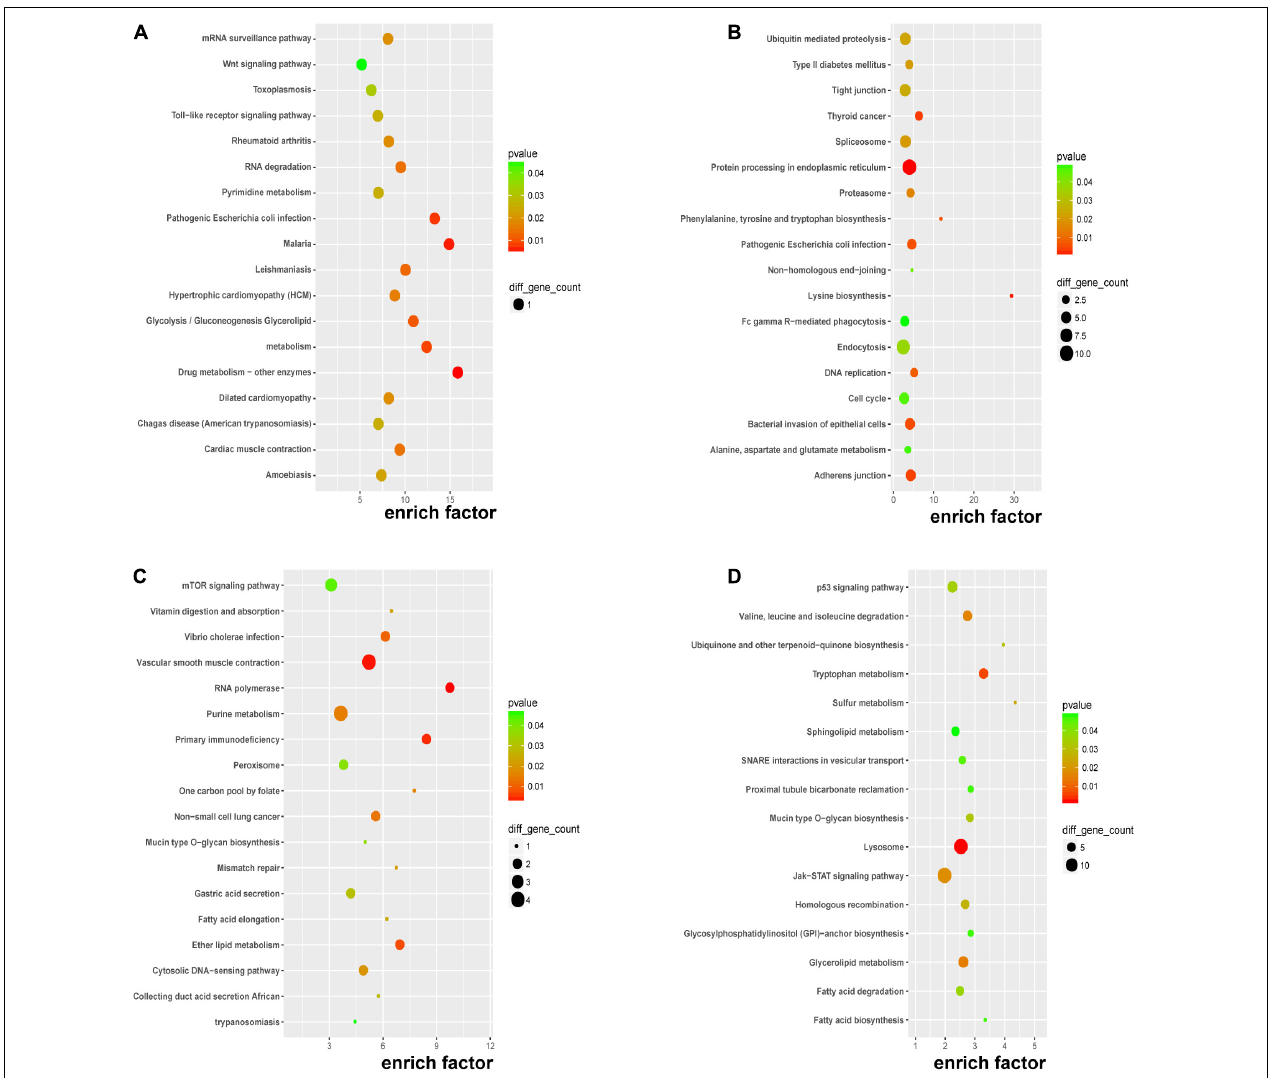
FIGURE 4 | KEGG pathway analysis of DERNAs. KEGG pathway analyses of DEmRNAs (A) , host genes of DEcircRNAs (B) , cis- regulated genes of DElncRNAs (C) , and trans- regulated genes of DElncRNAs (D)